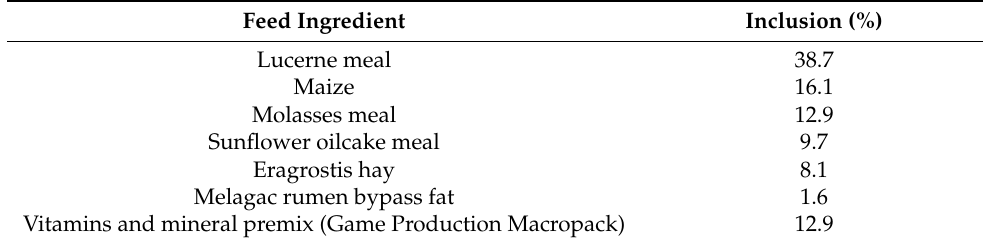
Table 1. Feed ingredients and inclusion rates for the total mixed ration fed to male impala on an ad libitum basis in the intensive production